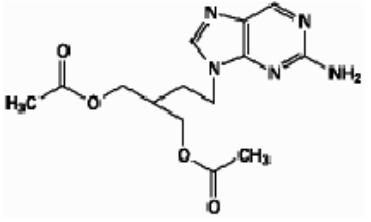
Figure 1. Structure of